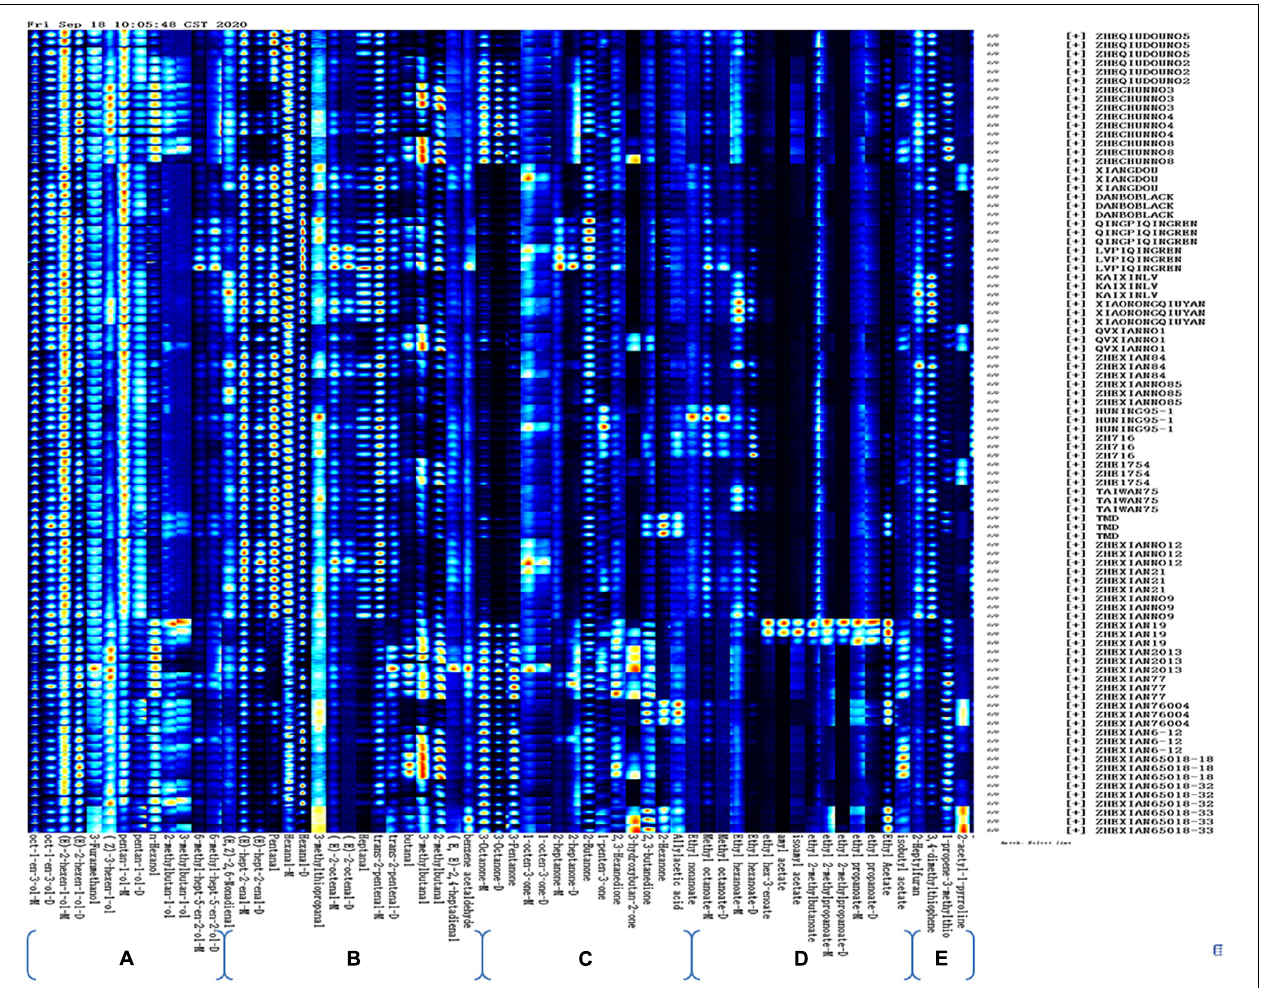
FIGURE 3 | Gallery plot of the signal peak areas obtained from 30 vegetable soybean cultivars. (A) Alcohol compounds; (B) aldehyde compounds; (C) ketone compounds; (D) ester compounds; and (E) other